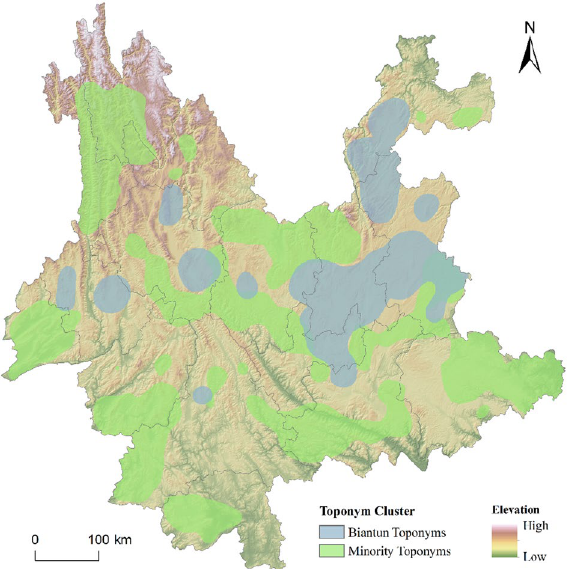
Figure 3. Cluster regions of Biantun toponyms (BTT) and minority toponyms. The map was created in ArcGIS Pro v.2.7: https:// www. esri. com (Esri, California, USA). The final layout was created in ArcGIS Pro v.2.7: https:// www. esri. com (Esri, California,